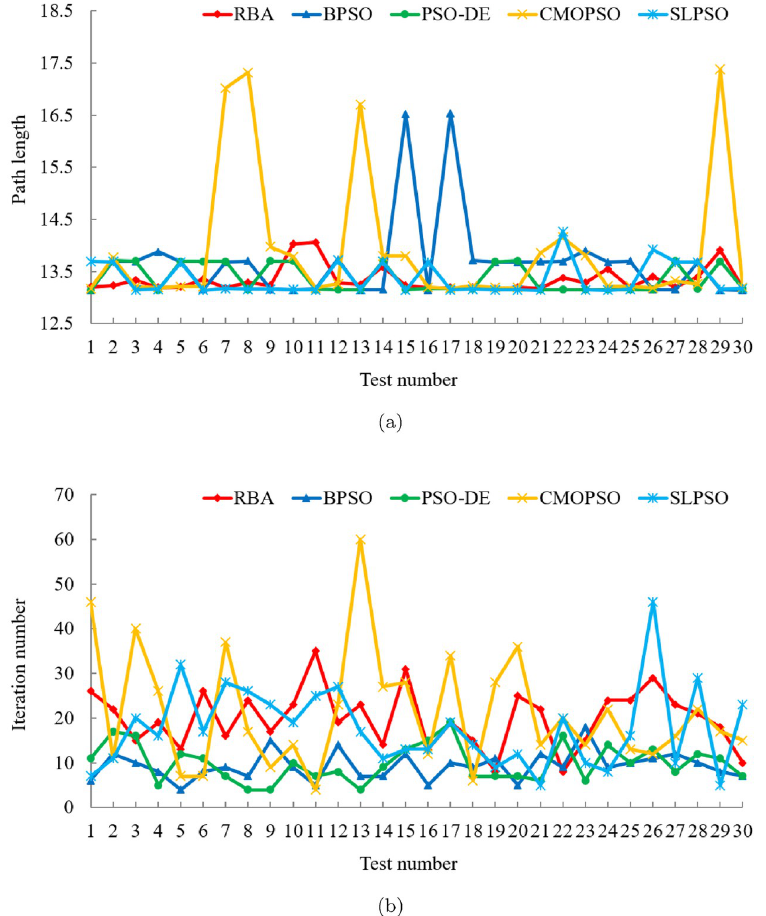
Fig 7. Experimental results of five algorithms in test case 2. (a) Path length. (b) Iteration number.